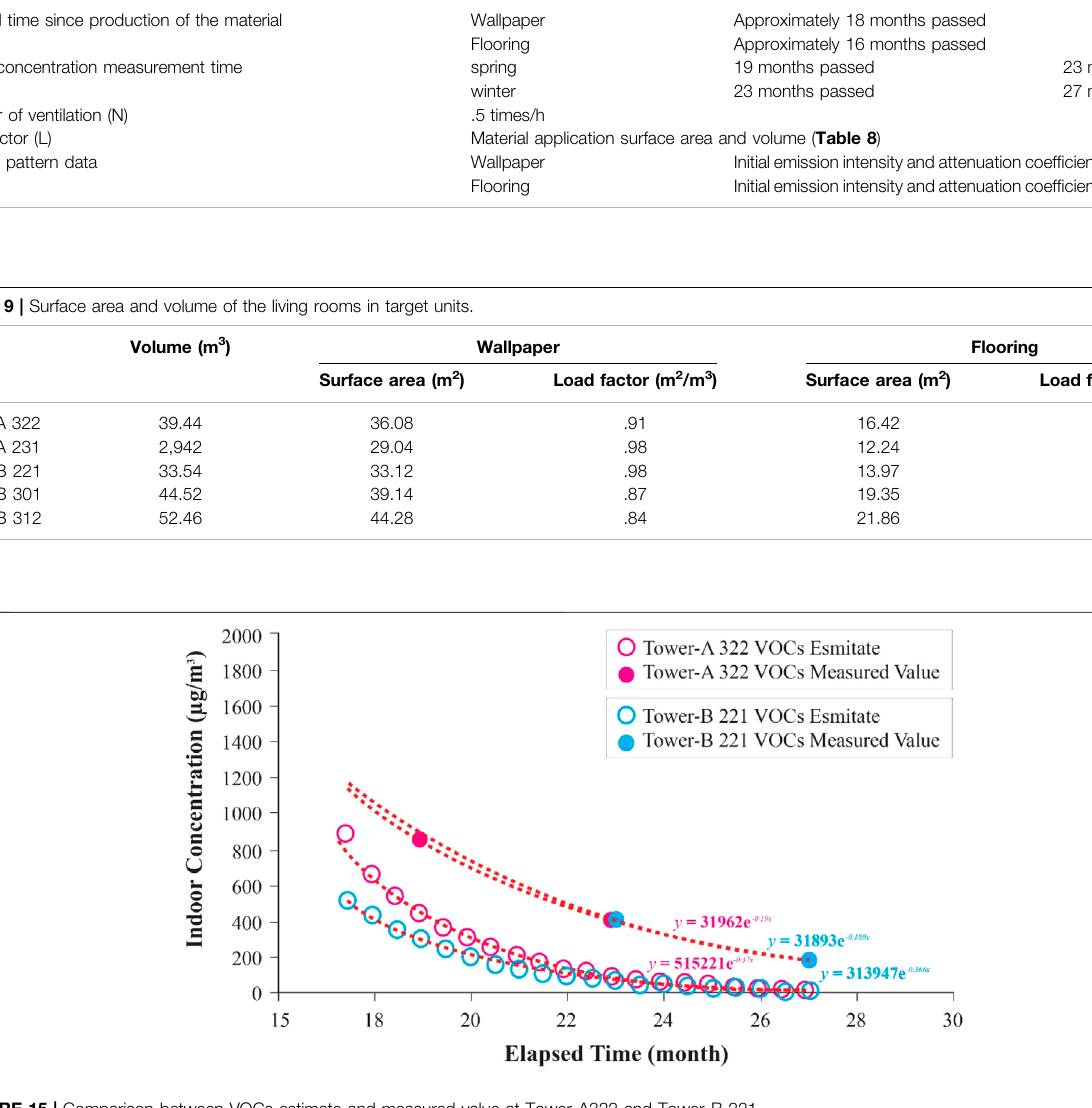
FIGURE 15 | Comparison between VOCs estimate and measured value at Tower-A322 and Tower-B 221.